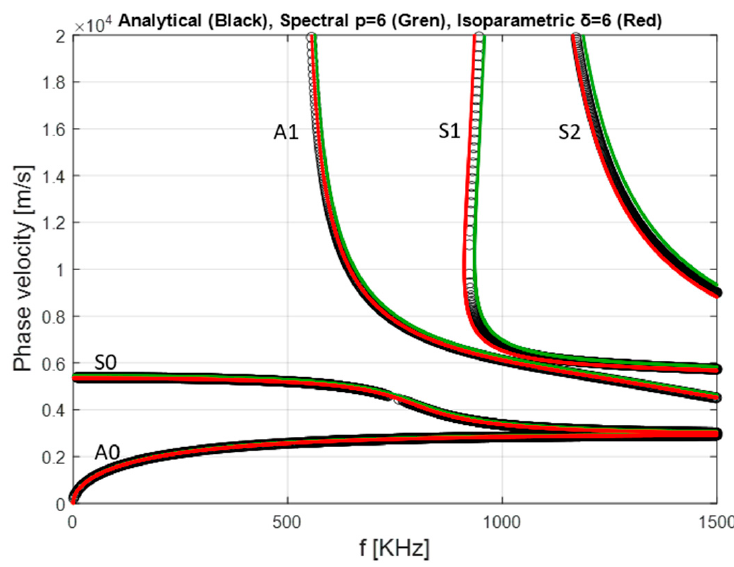
Figure 5. Phase velocity dispersion curves were calculated by SBFEM with isoparametric and spectral elements for a 3 mm-thick isotropic plate. Symmetric Sn and antisymmetric An ( n = 0, 1, 2, ...) modes.